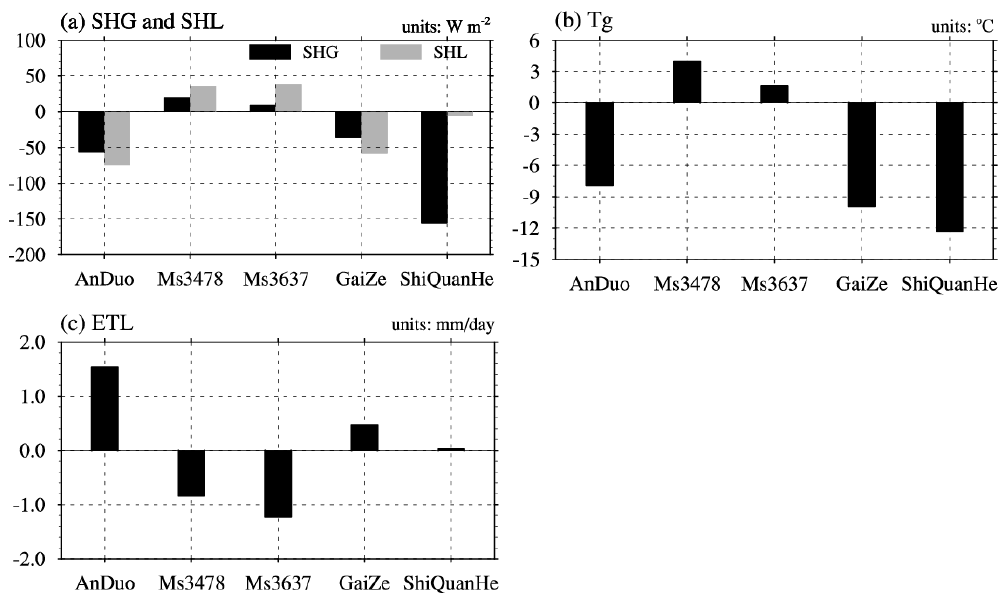
Figure 5. The variations in the sensible heat flux from the ground (SHG), sensible heat